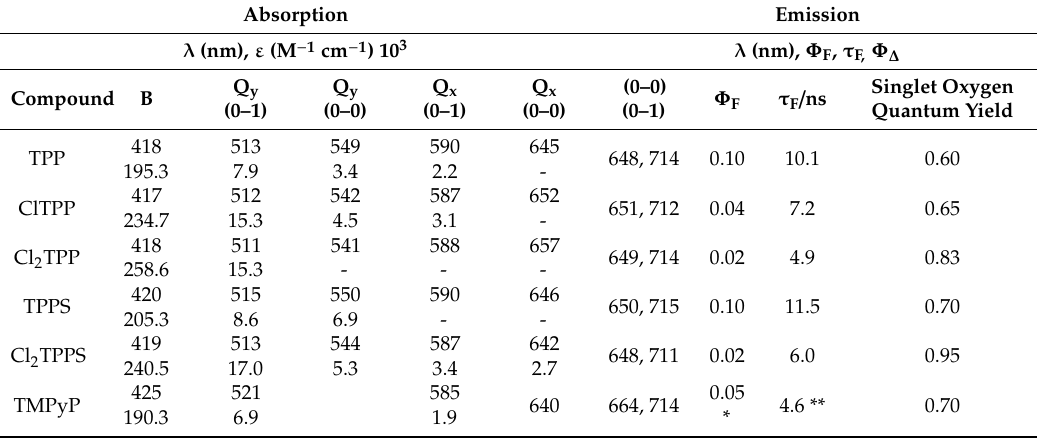
Figure 2. Normalized electronic absorption and emission spectra of the studied porphyrins measured in DMSO solution at room temperature. Table 1. Optical and photochemical properties of the porphyrins determined in